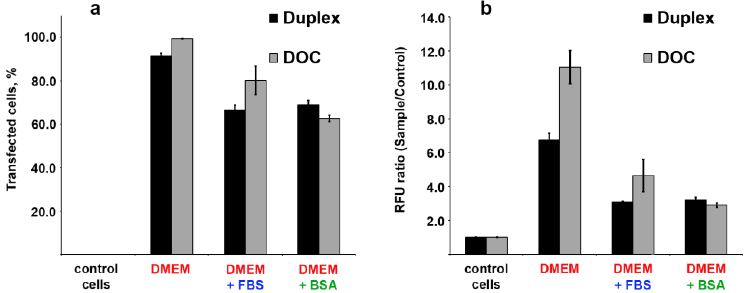
Figure 7. Cellular uptake of fluorescently labelled DOC (FAM-D-17 PG ) and its duplex (D-17 PG / FAM-17 (cid:48) ) estimated by flow cytometry after 4 h incubation of HepG2 cells with conjugates and additional followed 14 h without it: ( a ) percentage of FAM-positive HepG2 cells in the population; ( b ) normalized median value of the cell fluorescence to the autofluorescence of control cells. The highest transfection e ffi cacy was achieved for cells treated with FAM-D-17 PG in DMEM (Figure 7a,b). All cells were transfected (Figure 7a), and the median value of their fluorescence intensity exceeded that of cells’ auto-fluorescence 11 ± 1 times (Figure 7b). High e ffi cacy of transfection was also reached for cells transfected with duplex D-17 PG / FAM-17 (cid:48) in DMEM (Figure 7a). Surprisingly, the median value of cells’ fluorescence was almost two times lower than for cells treated with a single stranded dodecyl-containing oligonucleotide (Figure